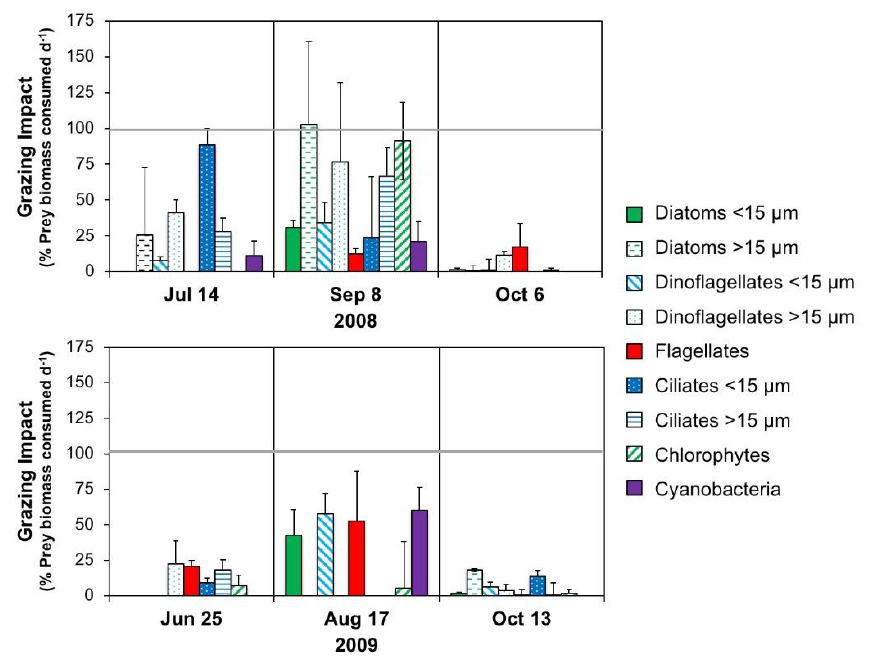
Figure 12. Copepod grazing impact, measured as % of prey population biomass consumed per day by adult female Acanthocyclops robustus , determined from incubation experiments conducted in Vancouver Lake on three dates in ( a ) 2008 and ( b ) 2009. Data from [46].